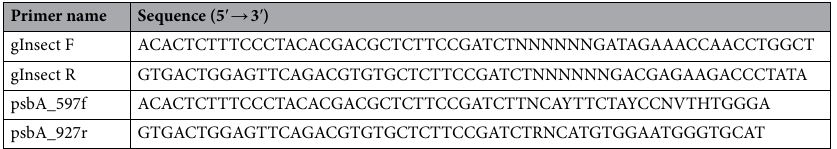
Table 1. PCR primers used in the present